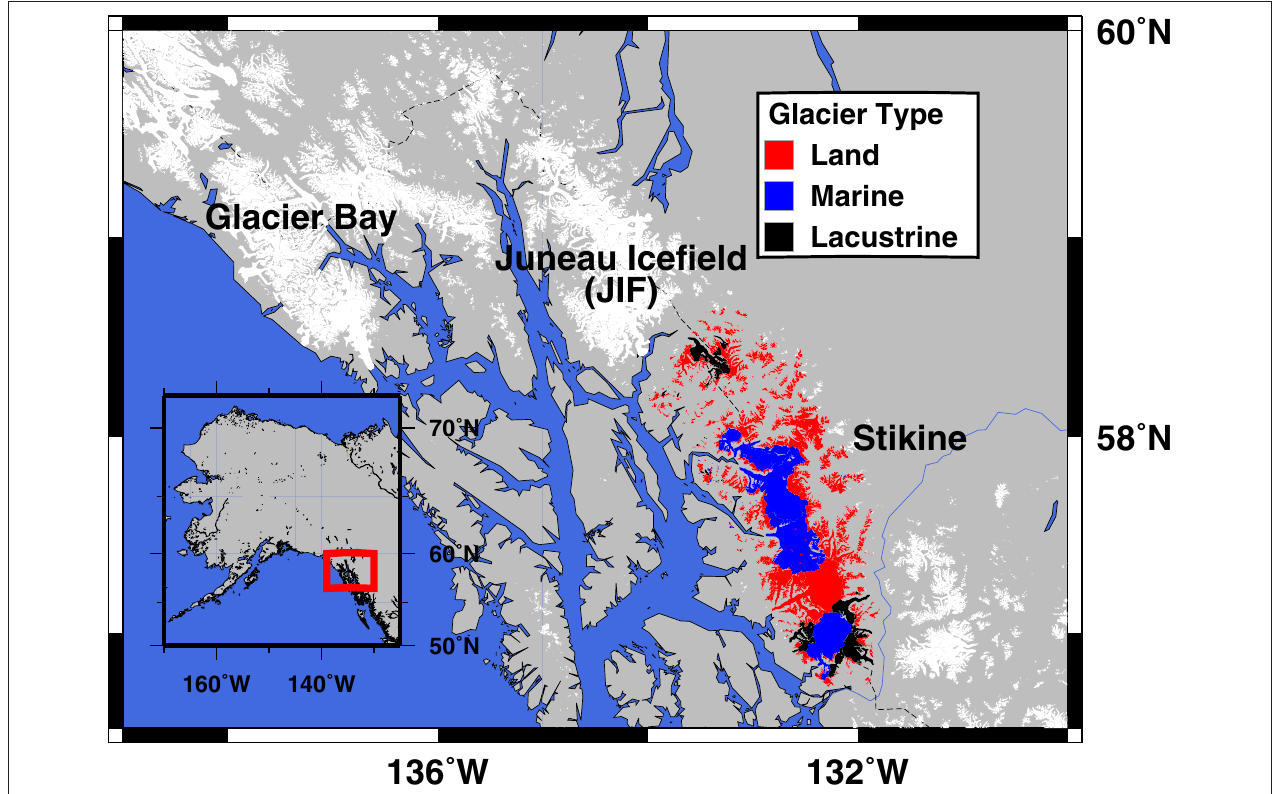
FIGURE 1 | Glaciers of southeast Alaska. Study area consists of Stikine Icefield glaciers where terminus type is color-coded (red for land-terminating, blue for marine and green for lacustrine) and covers approximately 5800 km 2